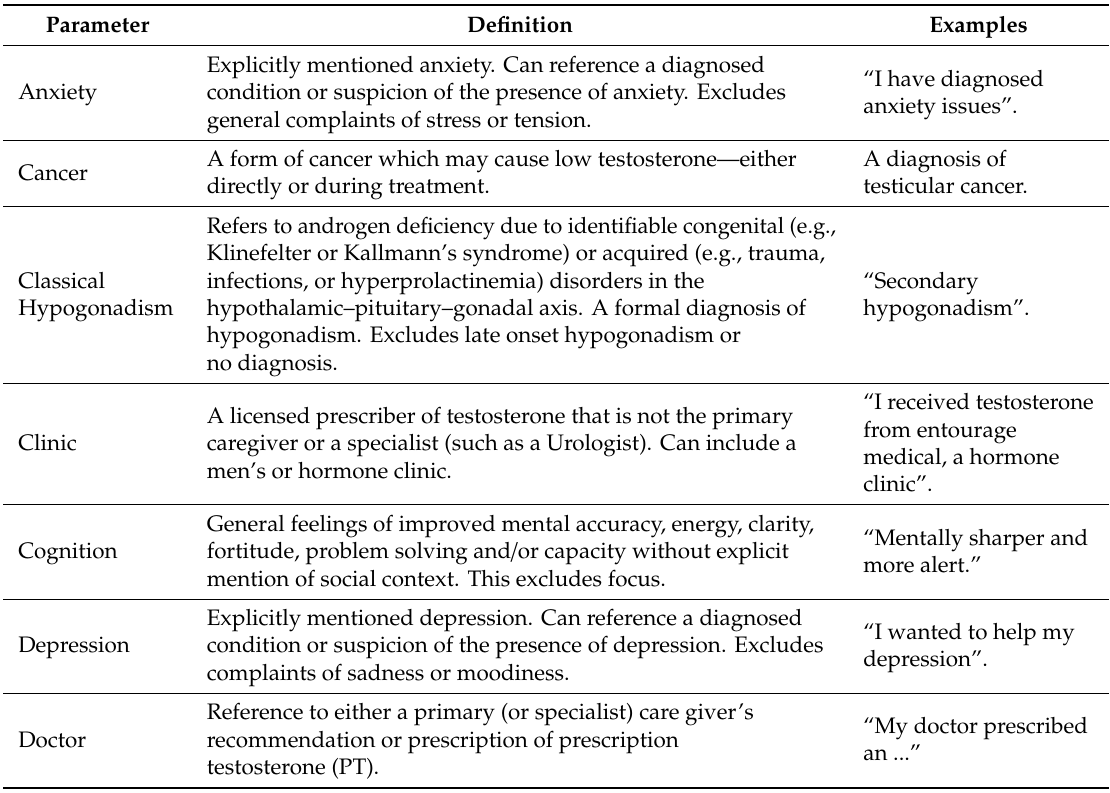
Table 1. Coding scheme for open-ended survey